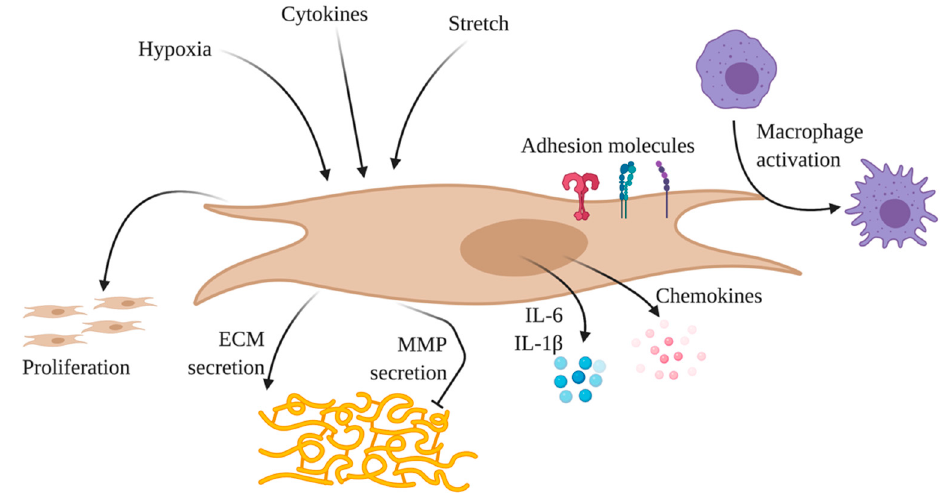
Figure 3. Activated fibroblasts drive PAH pathogenesis. Pulmonary artery adventitial fibroblasts respond to multiple stimuli and then propagate inflammation in PAH. In response to inflammatory cytokines, mechanical stretch, and hypoxia, fibroblasts adopt an activated, pro-inflammatory state. This phenotype is characterized by the overexpression of surface adhesion molecules and other inflammatory surface receptors, and secretion of cytokines and chemokines, importantly IL-6, IL-1 β and CCL2. Together, these molecules stimulate both the adhesion and activation of nearby macrophages to propagate the inflammatory response. Activated fibroblasts also alter extracellular matrix homeostasis, secreting ECM proteins, as well as matrix metalloproteinases (MMP) to break down ECM. Finally, fibroblasts themselves proliferate in response to abnormal stimuli encountered in PAH.